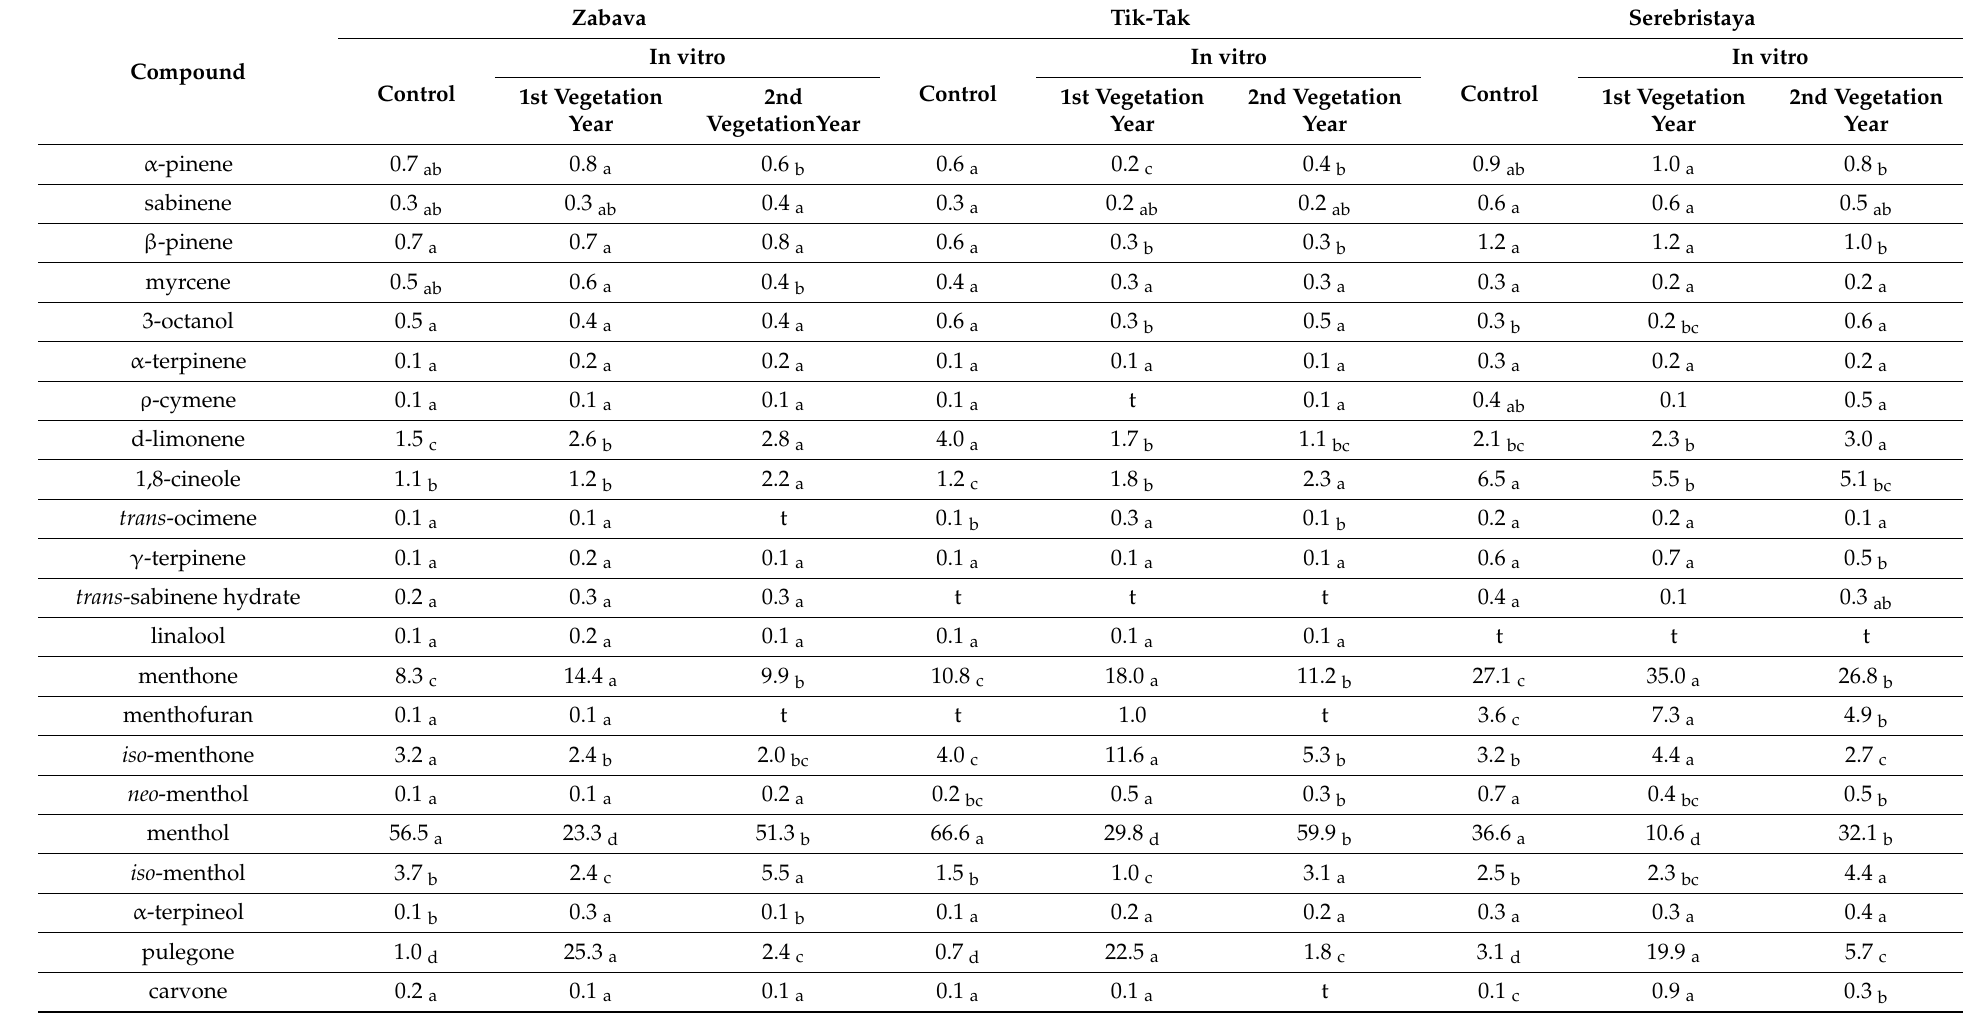
Table 2. The content of EO in plant biomass of peppermint cultivars, depending on the growing conditions, %. Zabava Tik-Tak Serebristaya In vitro In vitro In Compound Control Control Control